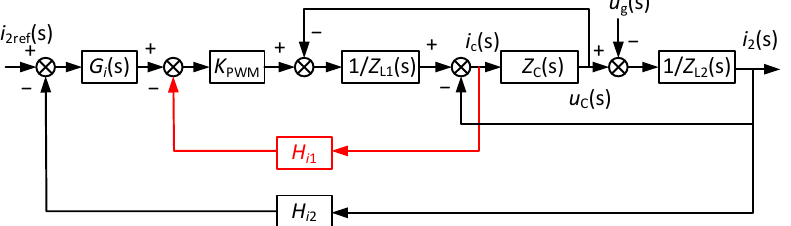
Figure 6. Block diagram of the FOGCI control system with capacitor current proportional feedback (Capacitor current proportional feedback can be eliminated if α + β ≠ 2).